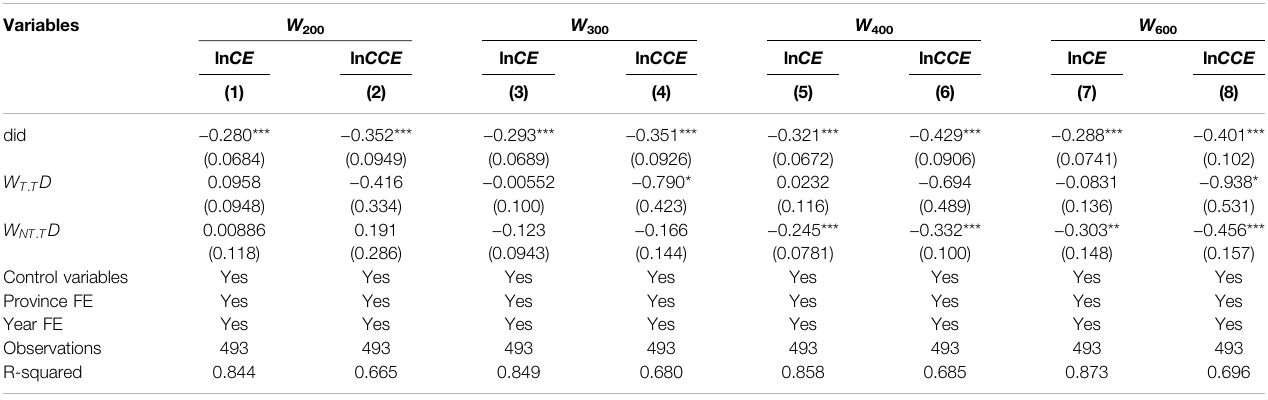
TABLE 6 | Estimation results of the SDID model for the pilot covering different ranges.